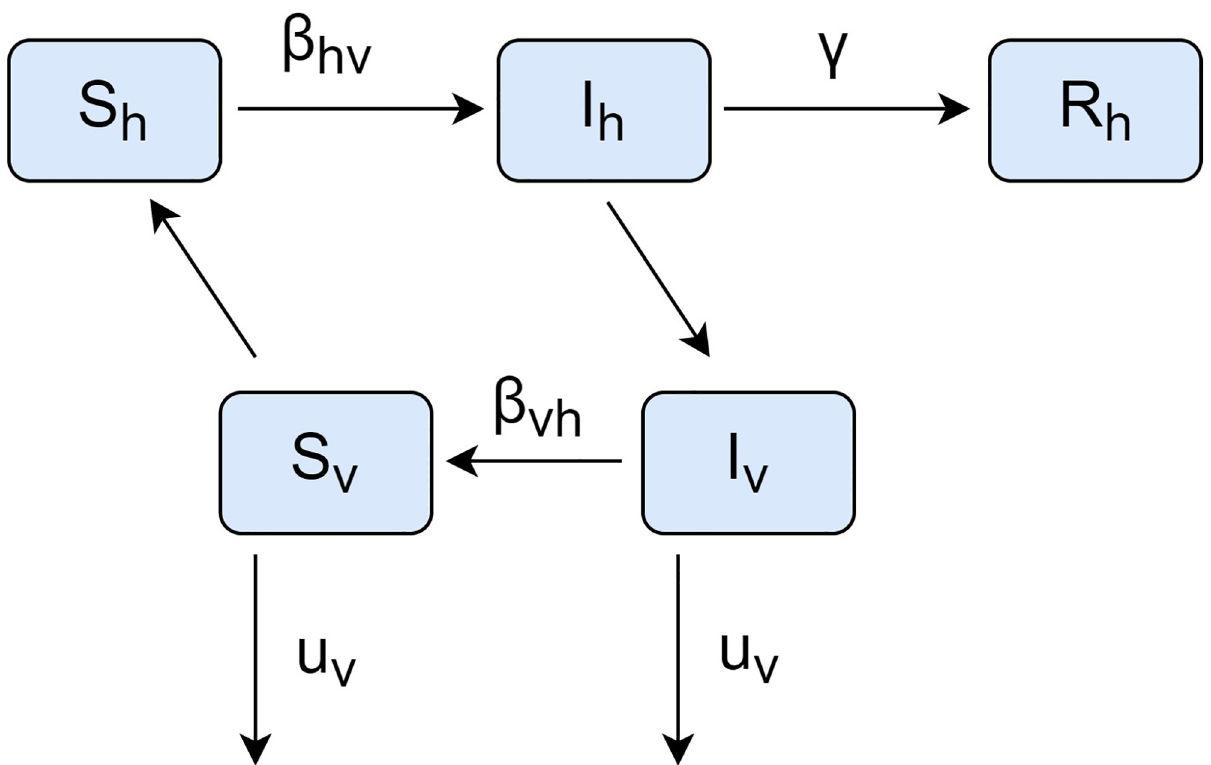
: vector-to-host transmission rate; β vh